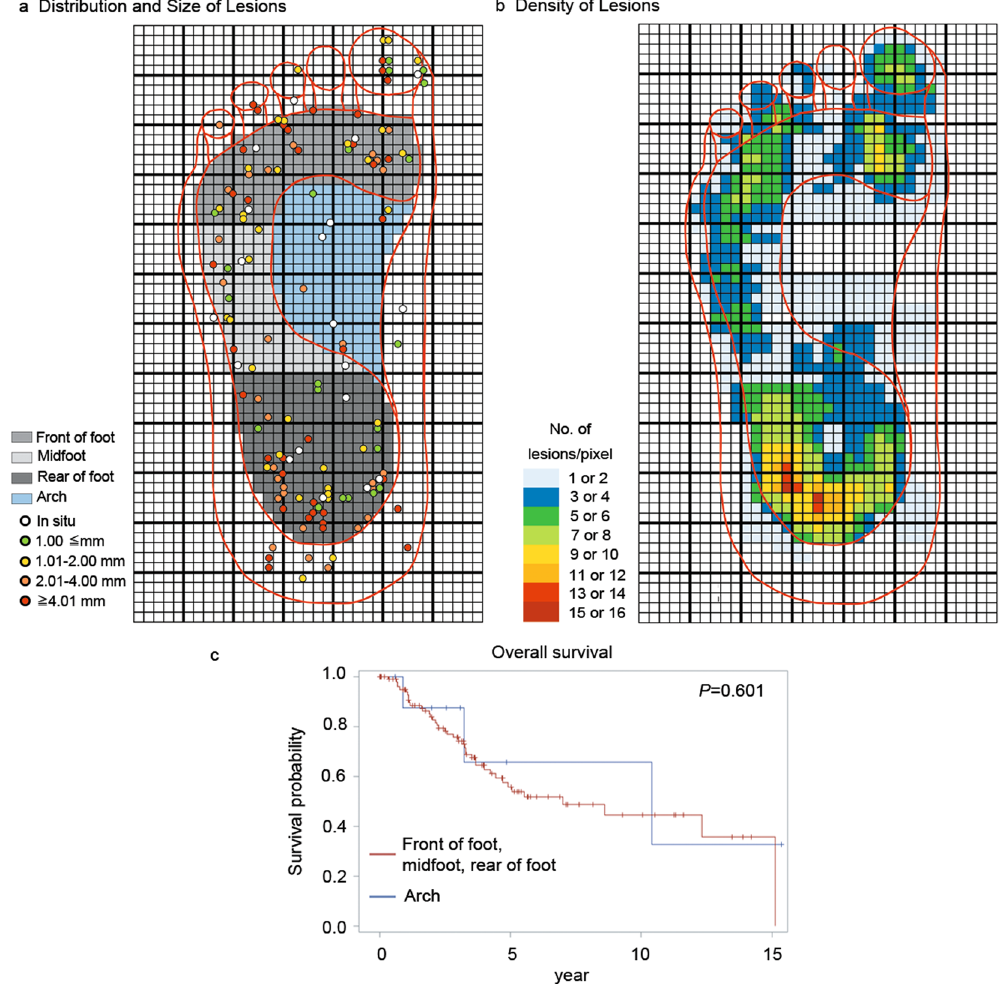
Figure 1. Distribution of acral melanomas in the plantar area. ( a ) The four areas of the sole are illustrated. The center of each lesion is marked and color-coded conforming to its Breslow thickness. ( b ) The number of lesion areas in each pixel is demonstrated on a color scale. Each pixel measures 5 mm by 5 mm. ( c ) Kaplan-Meier curves of survival in 114 acral melanomas. No overall survival differences were found between melanomas developed on stress-bearing and non-stress-bearing areas ( P = 0.6, log-rank